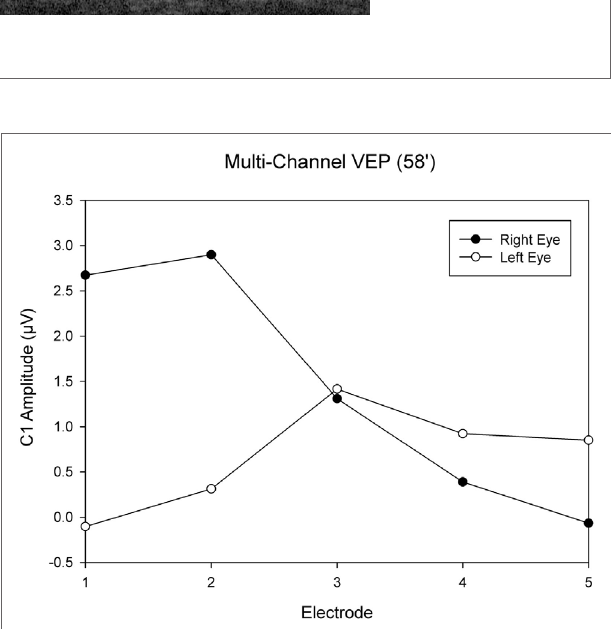
FigUre 2 | Visual evoked potential (VEP) topography revealed asymmetric response localization over the two cerebral hemispheres in the left and right eye pattern onset